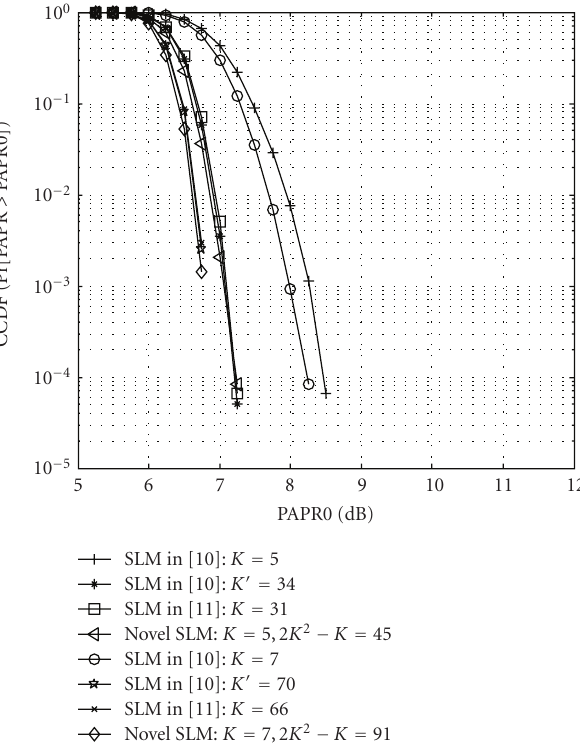
Figure 6: PAPR reduction performance of the novel SLM scheme and the SLM schemes in [10,